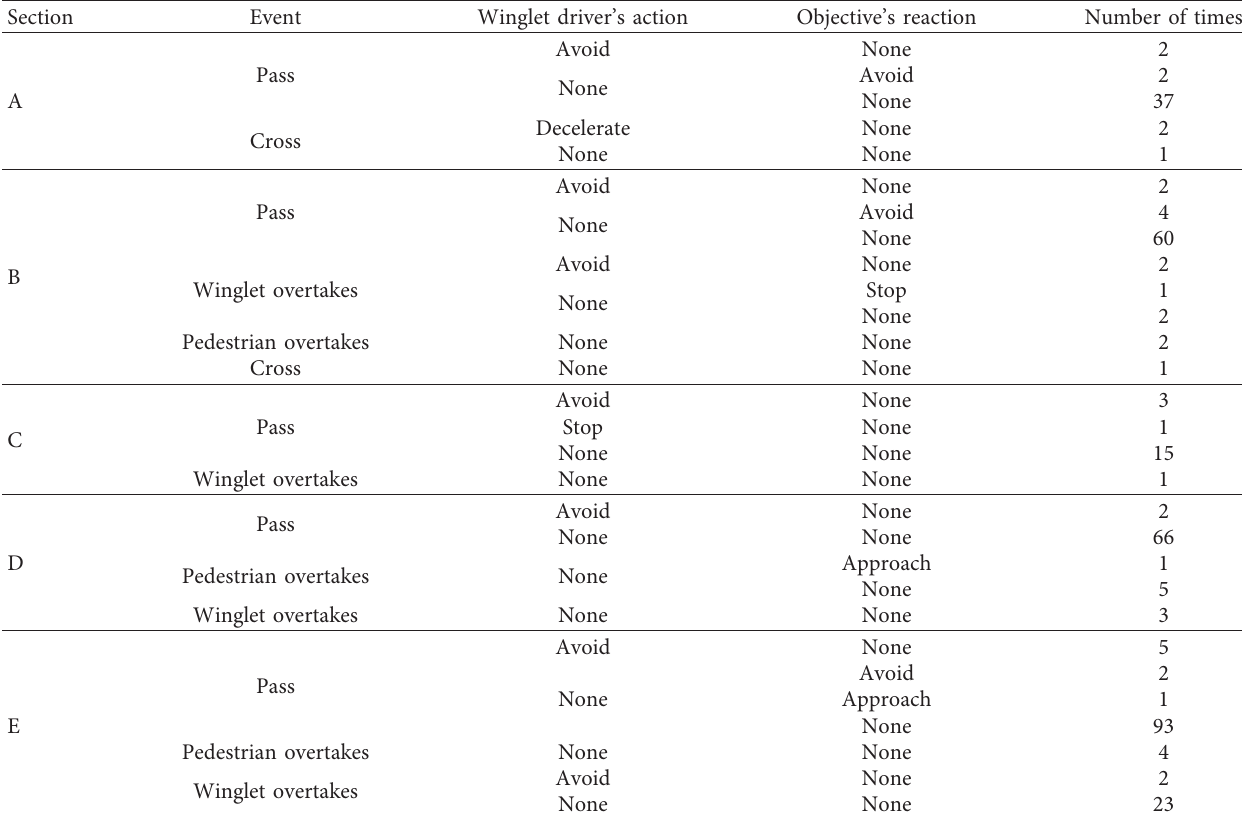
Table 6: Scenario 1 events categorized according to area (objective: pedestrian).